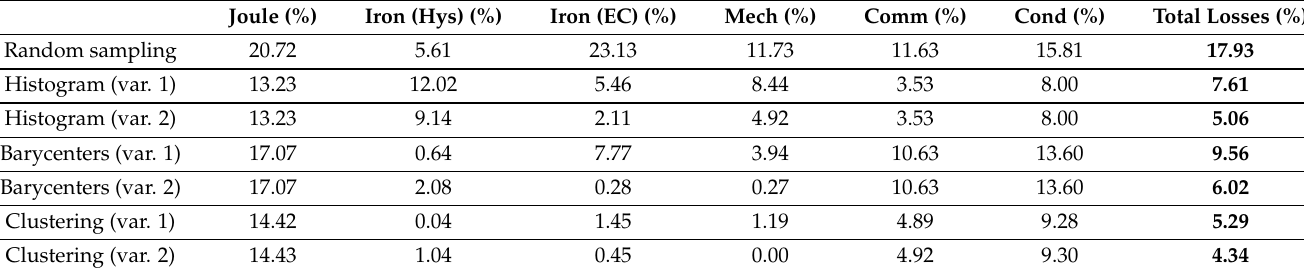
Table 1. Deviation between the proposed cycle reduction techniques over 10 interest points and real cycle losses. Joule (%) Iron (Hys)